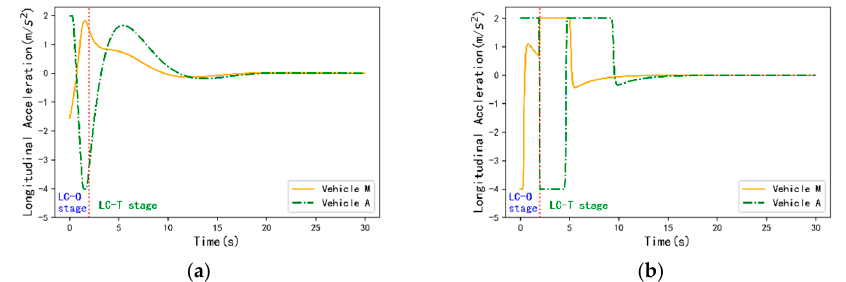
Figure 9. The longitudinal accelerations of vehicles M and A of the two control strategies in scenario 1. ( a ) The proposed CLC control strategy, ( b ) CACC_Sine control strategy.